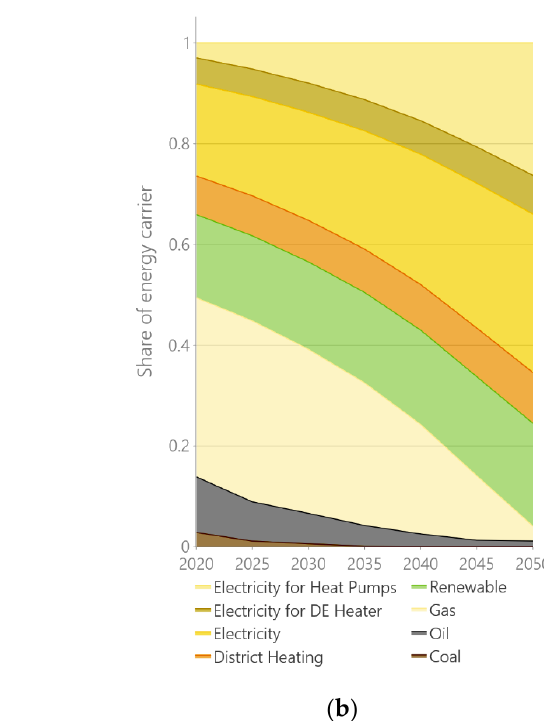
( b ) Figure 4. Development of FEC per sector ( a ) and energy carrier ( b ) in Europe [30]. To delve deeper into the sector model results, we investigate the private household